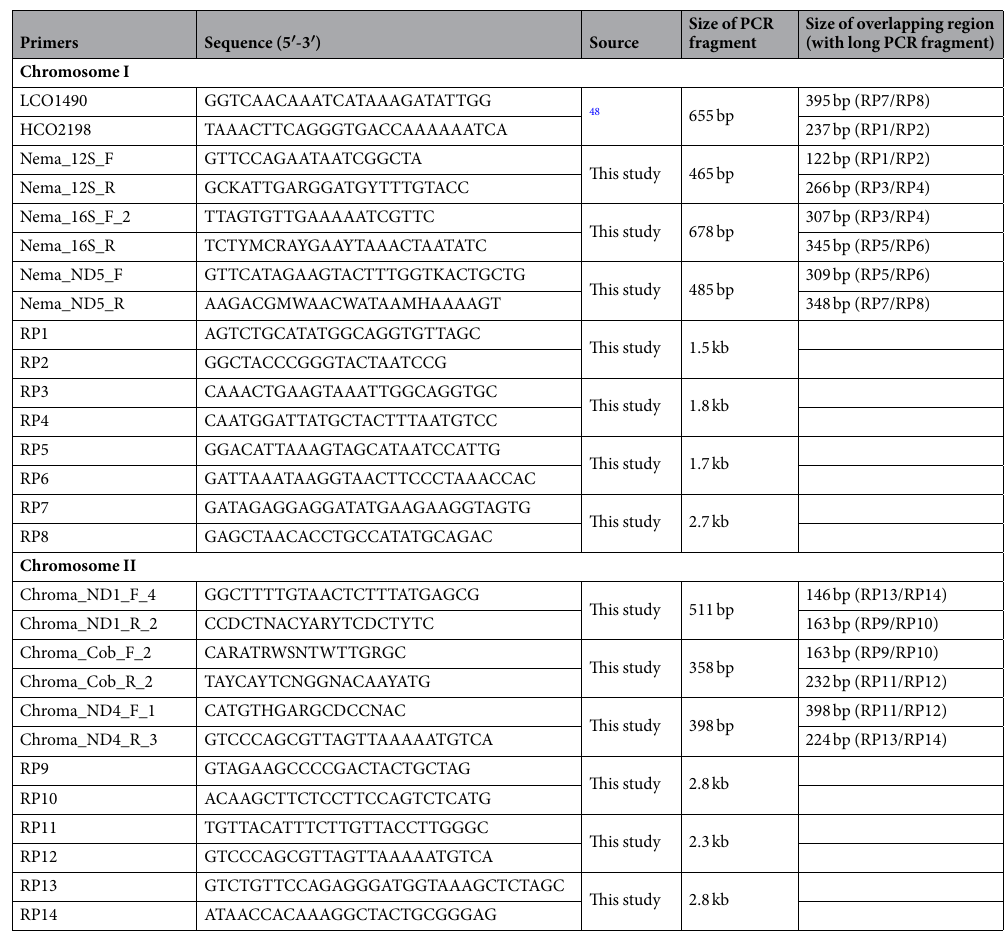
Table 2. Primers used to sequence the complete mitochondrial genomes of Ruizia karukerae . IUPAC nucleotide ambiguity codes used are W (A or T), R (A or G), K (G or T), S (C or G), Y (C or T), M (A or C), D (A, C or T), H (A, G or T) and N (A, C, G or